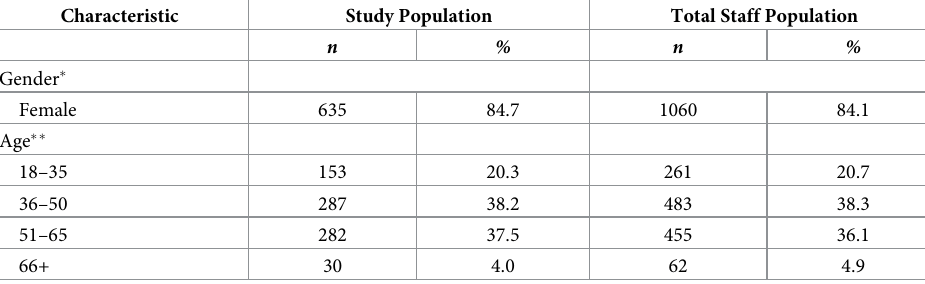
Table 1. Characteristics of study population and total staff